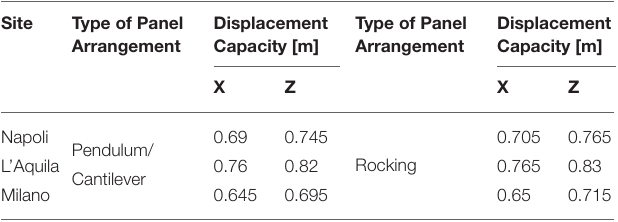
TABLE 1 | The displacement capacity for all panel arrangement for all sites.